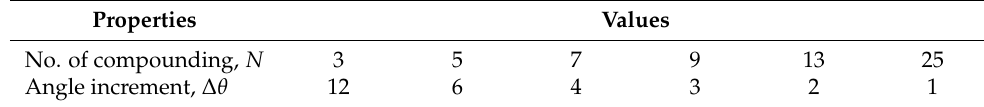
Table 1. Compounding